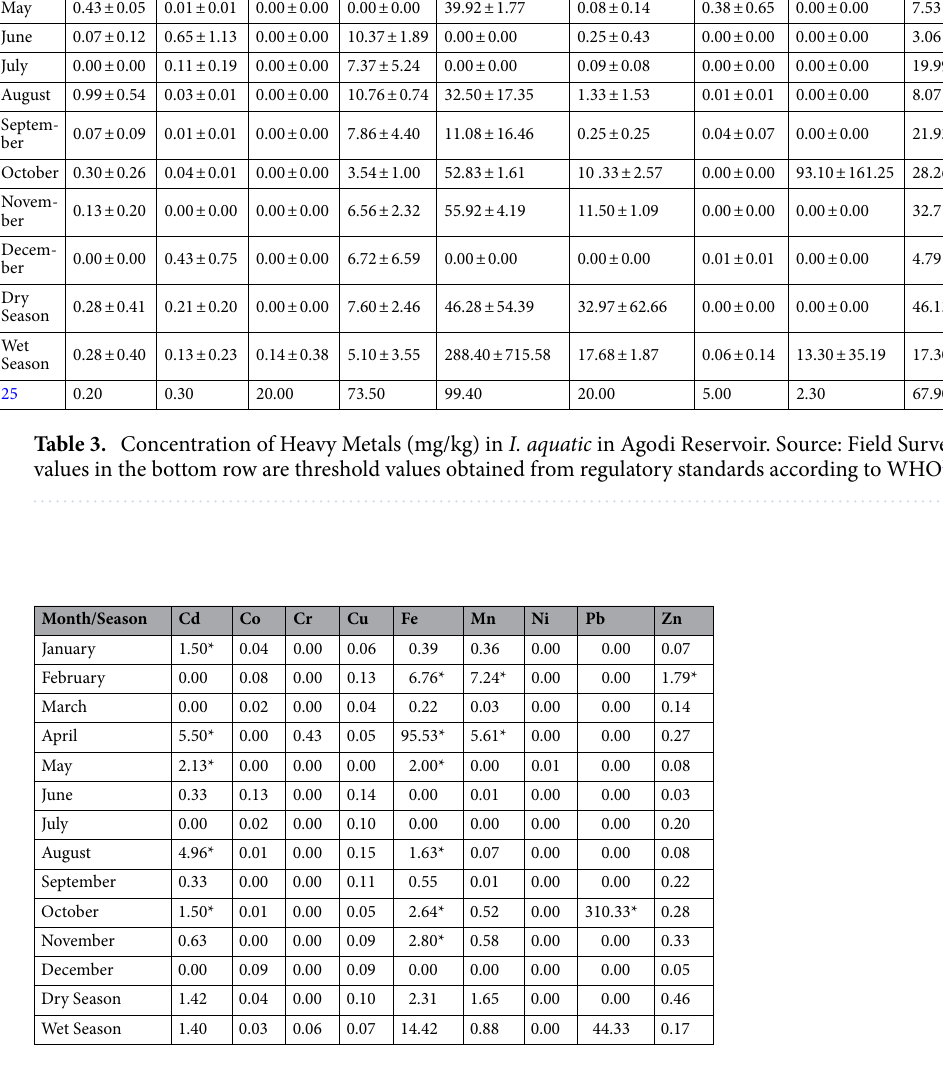
Table 4. Ecological Risk Quotient of Heavy Metals in I. aquatic in Agodi Reservoir. ERQ values with asterisk ‘*’ are above the ecological risk limit (Source: Field